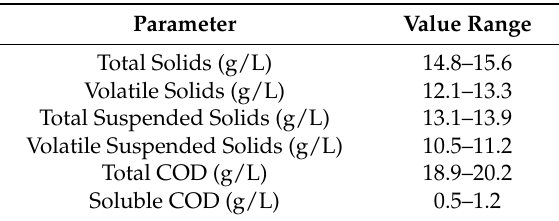
Table 1. Characteristics of mixed sludge. The range of values in four consecutive batches of sludges for which each analyses was conducted in triplicate. COD: chemical oxygen